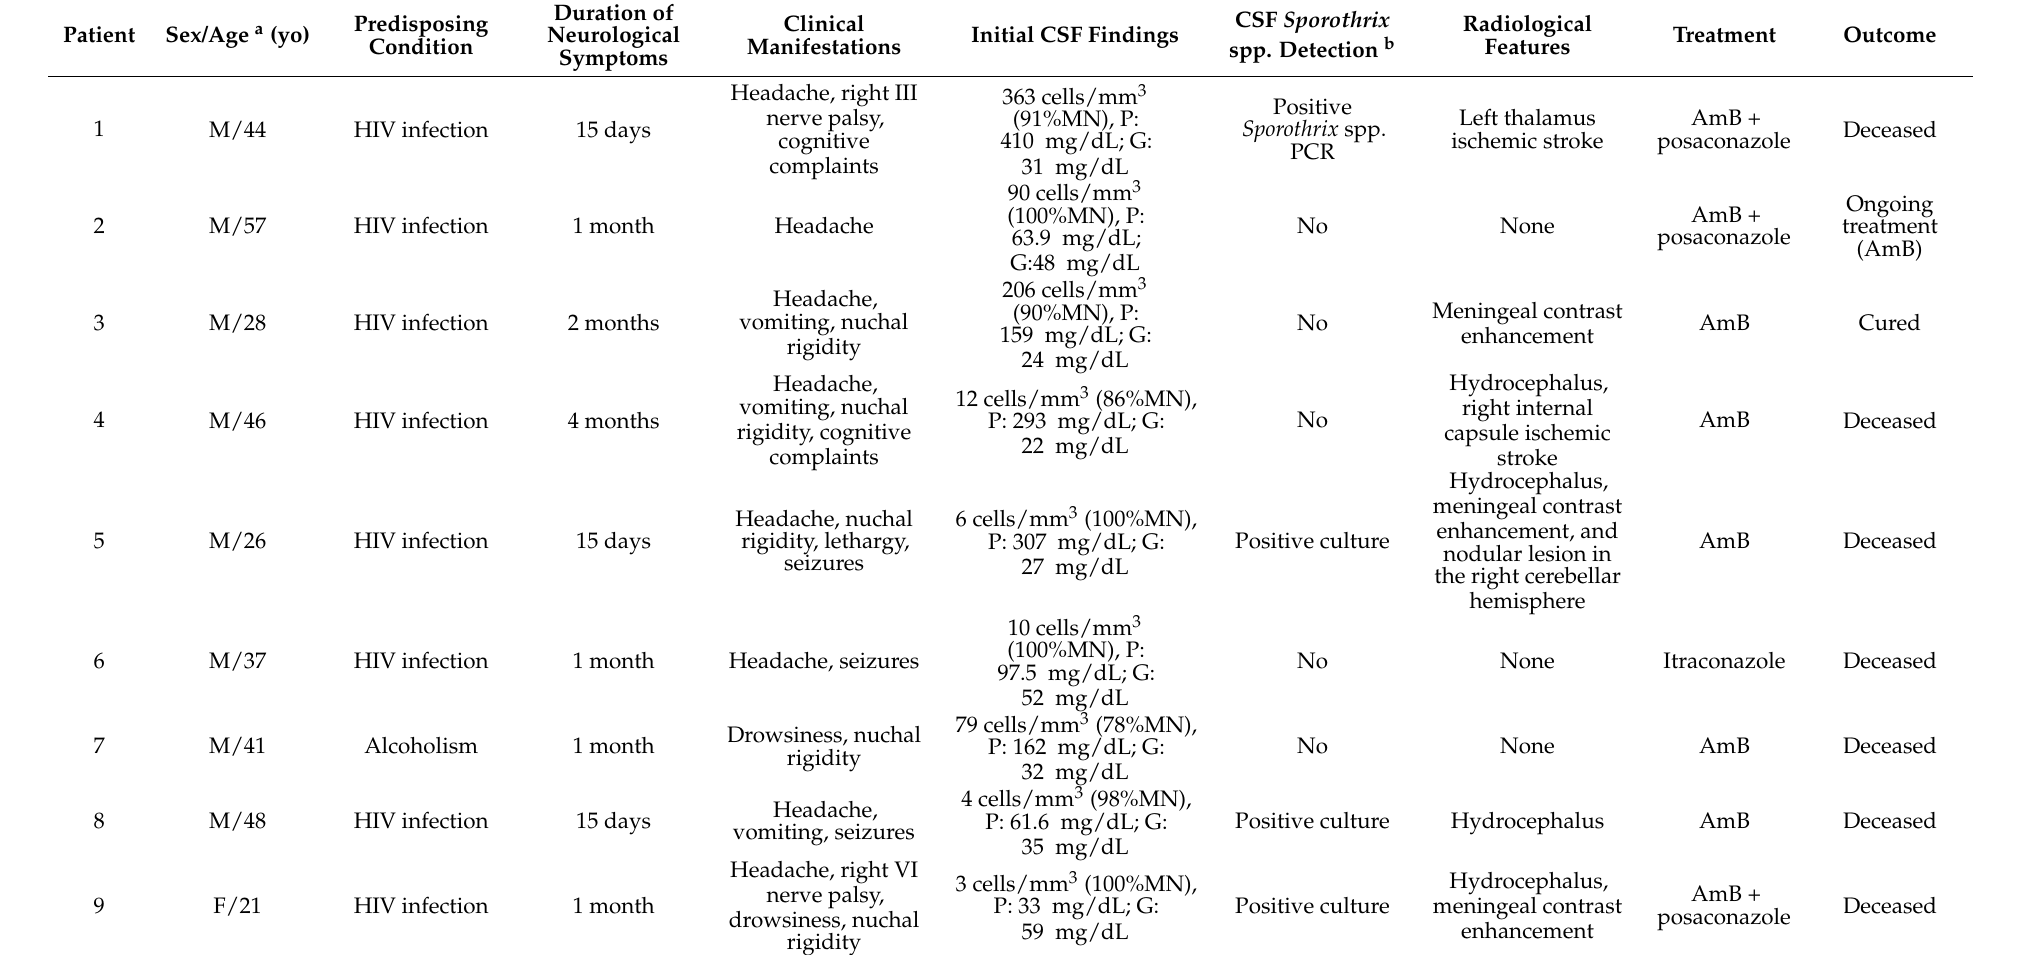
Table 3. Characteristics of patients with central nervous system sporotrichosis (Group